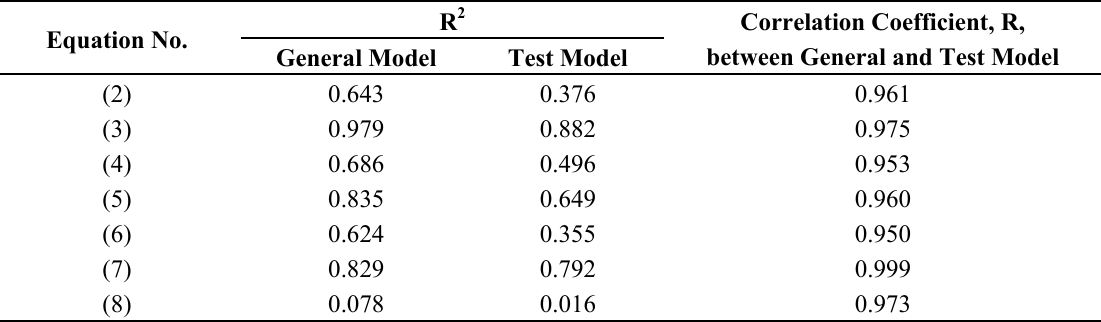
Table 8. Model validation results using the jack-knife